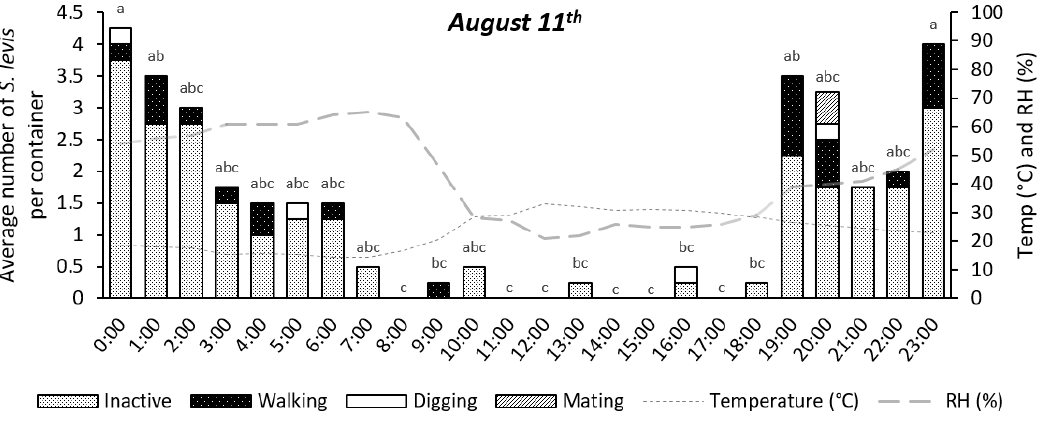
Figure 4. Number of visible S. levis adults per container at every hour on 11 August considering insect activity, temperature (temp) and relative humidity (RH%). Bars with mean values followed by same letter are not different at α = 0.05.